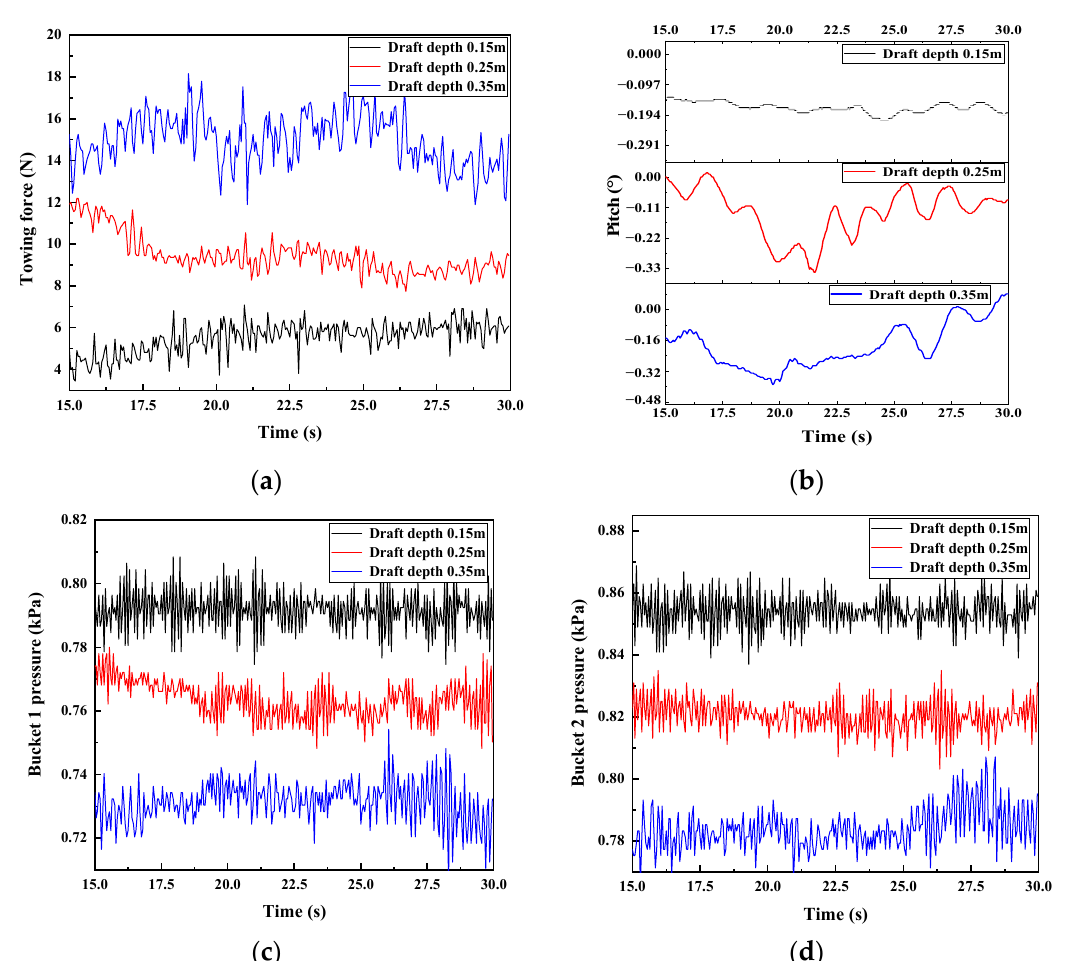
Figure 18. The dynamic response of the TBJF for different draft depths. ( a ) Towing force. ( b ) Pitch. ( c ) Bucket 1 pressure. ( d ) Bucket 2 pressure.